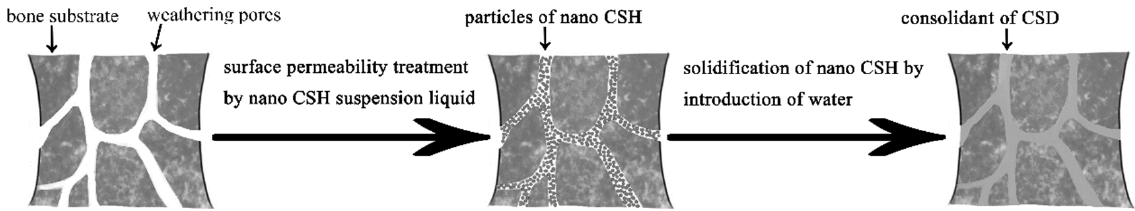
Figure 1. The schematic representation of the consolidation